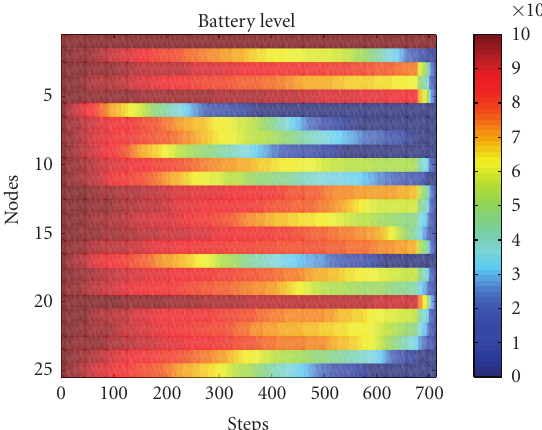
Figure 7: Battery level status for each sensor during iterations of the network, optimized considering F 5 , defined in Table 2 (average results over 10 trials).